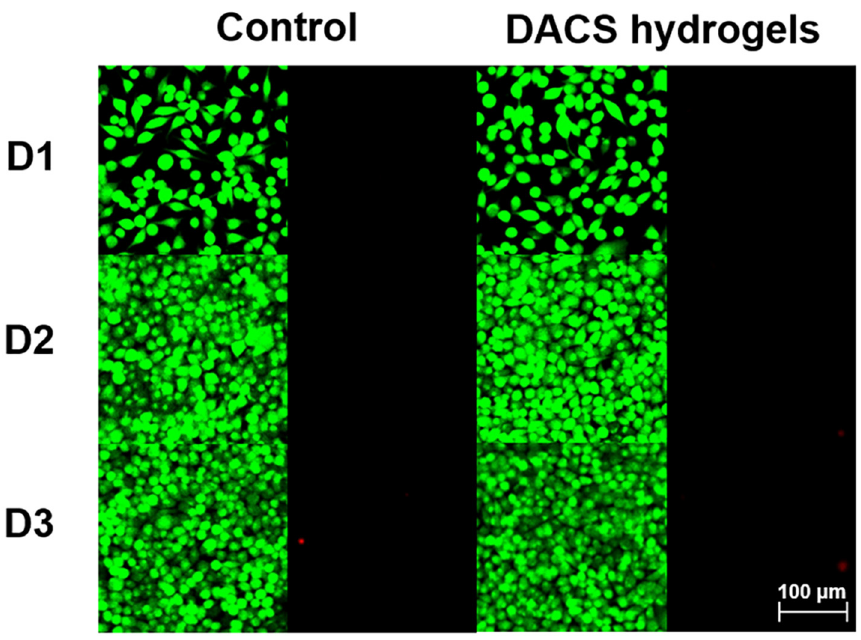
Figure 6. The fluorescence image of L929 mouse fibroblast cells cultured with control and DACS hydrogels leaching solution on the first (D1), second (D2), and third day (D3), respectively.